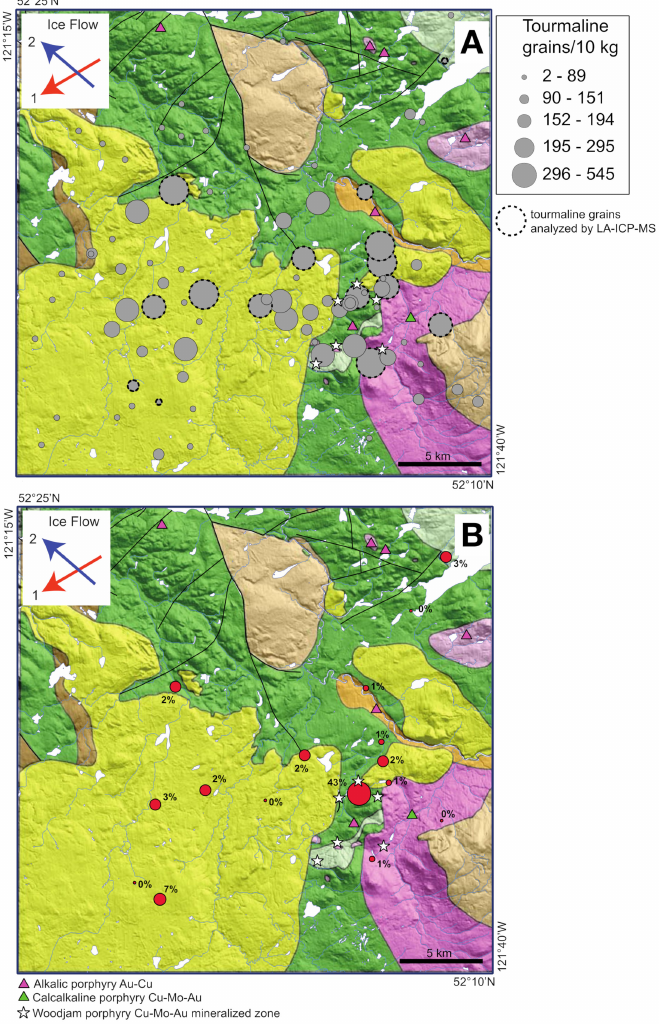
Figure 13. ( A ) Distribution of 0.25–0.5 mm tourmaline in the 2.8–3.2 specific gravity fraction of till samples down ice of the Woodjam porphyry Cu-Au deposits, counts normalized to 10 kg. White dots indicate samples for which the tourmaline grains were analyzed by MLA. ( B ) Percentage of tourmaline grains that were analyzed and that were identified as ‘porphyry-derived’ based on high concentrations of Sr, low concentrations of Zn and Pb, and their lack of inclusions. Bedrock geology from Logan et al. (2010) [181] and Plouffe and Ferbey (2017) [58]. Modified from Beckett-Brown et al. (2021)